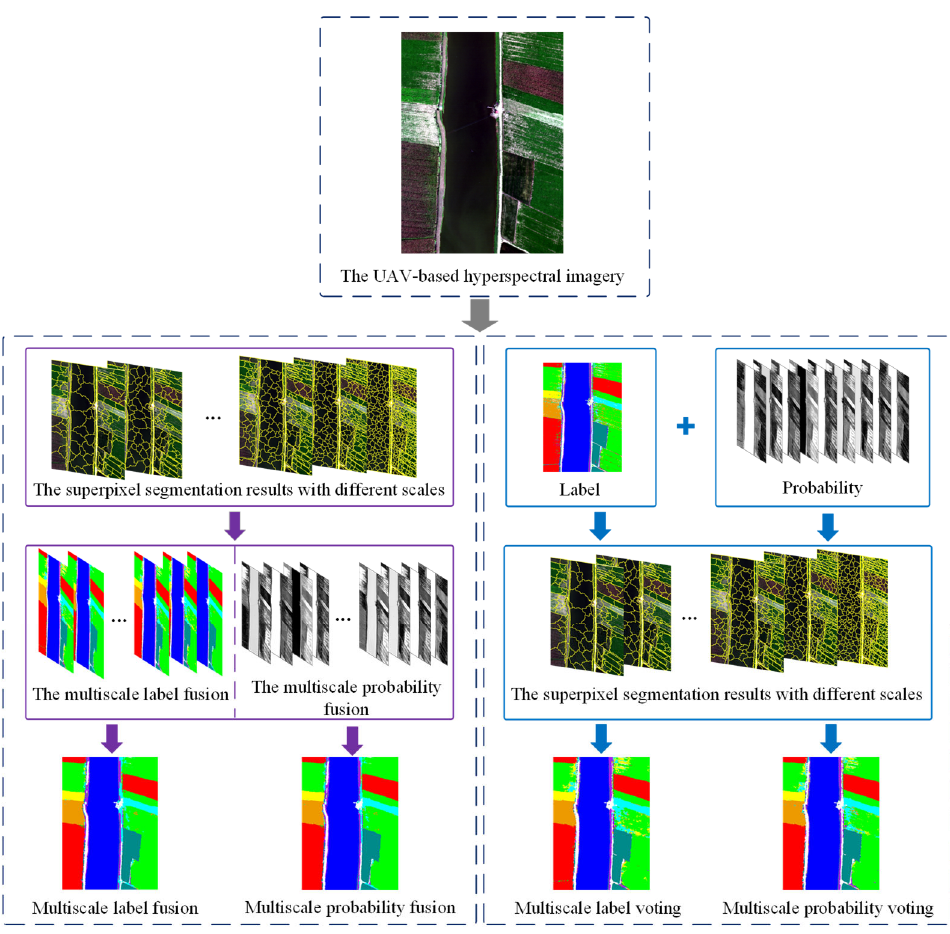
Figure 1. Flow chart of the research.